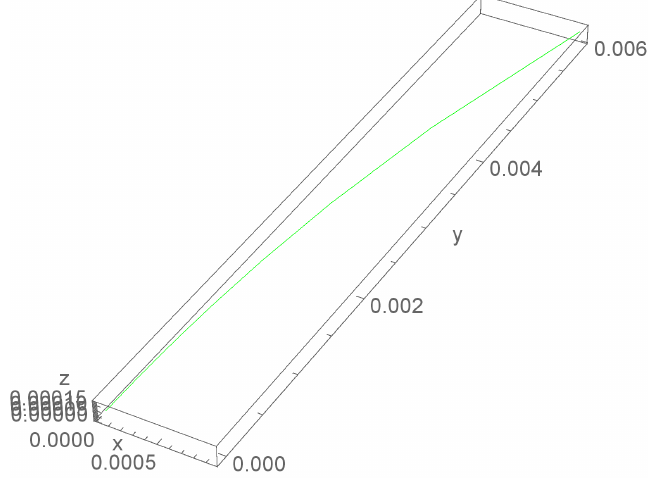
Figure 19. Attractor of system ( 3 ) when α = 0.5, β = 1.7, γ = 1.6, δ = 0.3, ζ = 0.7, η = 1.6, µ = 2.7, ε = 0.6, υ = 0.8, ρ = 1.11, σ = 1.11, ω = 0.2. with initial conditions x 0 = 0.002, y 0 = 0.0084 and z 0 = 0.0003.